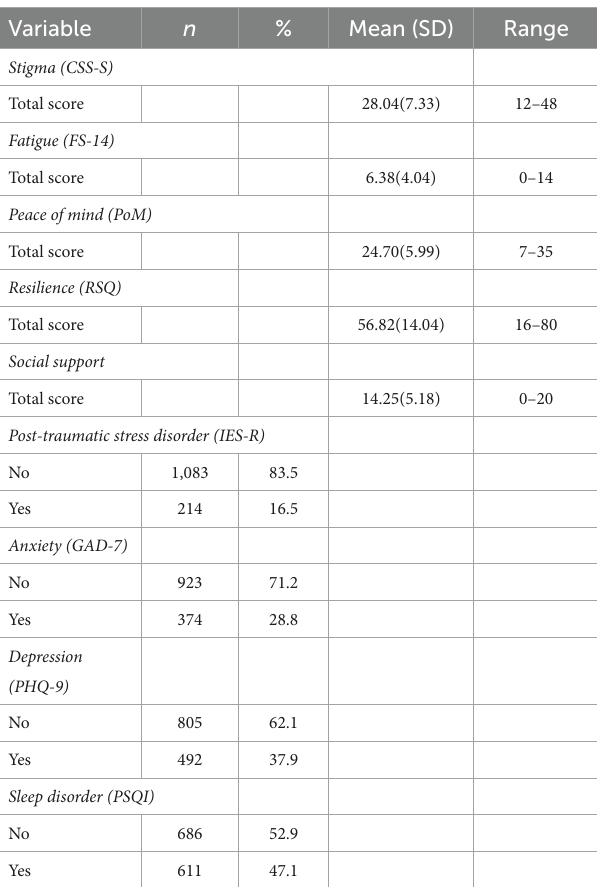
TABLE 2 Descriptive statistics for CSS-S, FS-14, PoM, RSQ, social support, IES-R, GAD-7, PHQ-9 and PSQI.